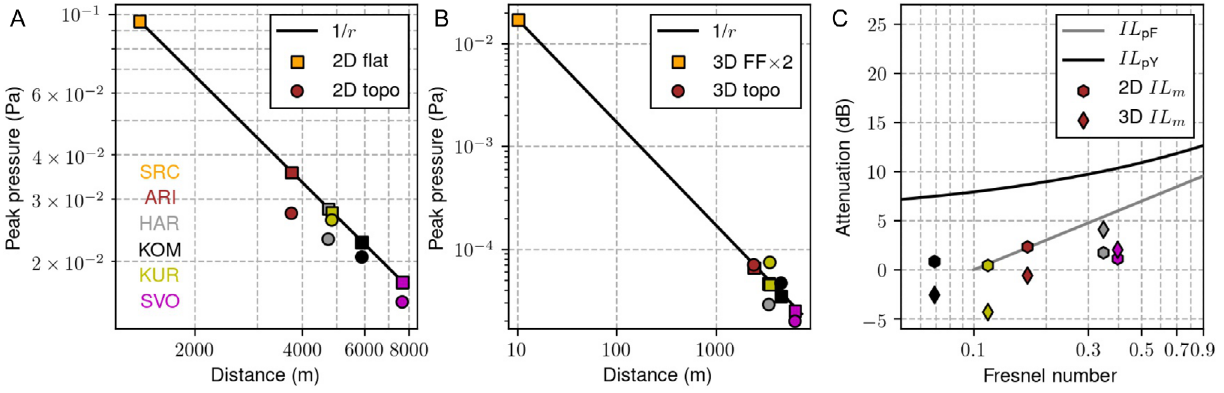
Figure 5: [A] Peak pressure of 2D synthetic waveforms at Sakurajima station distances for lower boundaries with topography (circles) and flat ground (squares). The orange square represents the approximate source pressure as recorded 10 m outside the boundary of the source region. [B] Peak pressure of 3D synthetic waveforms over Sakurajima topography (circles) [Kim and Lees 2014] and through the free field (FF, squares). Free field values are multiplied by two to approximate flat ground propagation. [C] Modeled insertion loss ( IL to predicted insertion loss according to Yamamoto and Takagi [1992] ( IL pY , Equation 3) and Fehr [1951] ( IL pF , Equation 4) for the 2D peak pressures (hexagons) and 3D peak pressures (diamonds) shown in Figure 5A and Figure 5B,